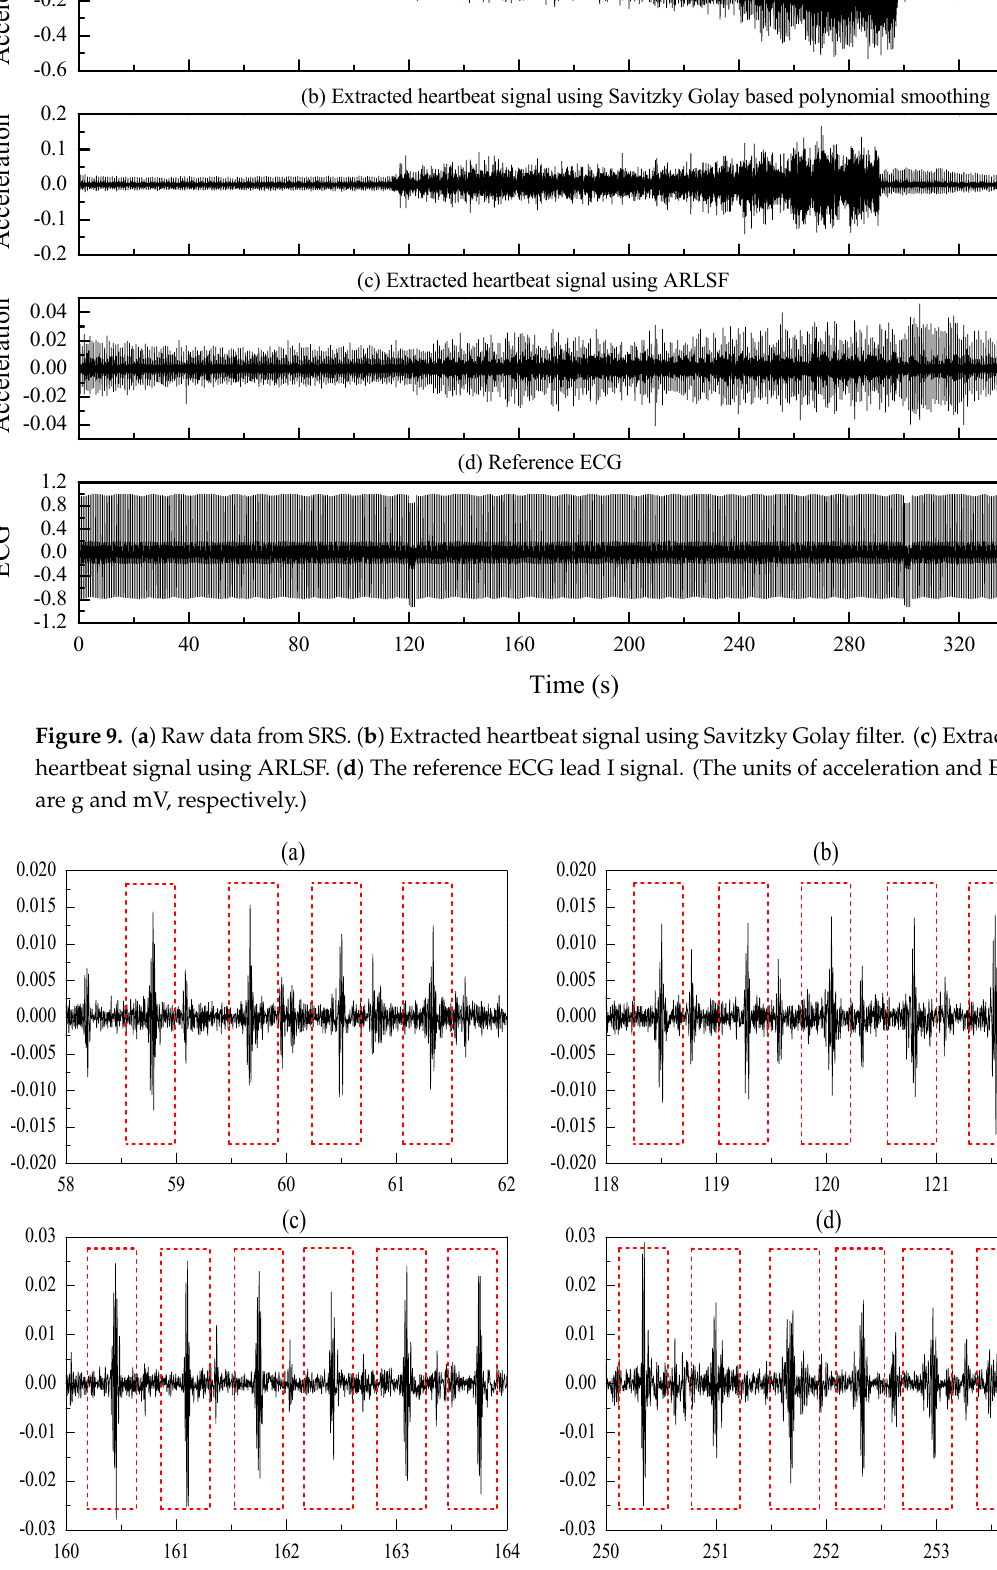
Figure 10. ( a – f ) Segmented signal during standing before walking, transitions from standing to walking, the first half of walking, the second half of walking, transitions from walking to standing, standing after walking. (The x ‐ axis and y ‐ axis are time in seconds and acceleration in gravity respectively.) 4.1. Heartbeat Detection Accuracy The standard ECG lead I recordings are the baseline references for heartbeat signals. Heartbeat detection accuracy is defined as the ratio of the detected SCG peaks divided by the detected ECG peaks. The detected SCG peaks are visually noticeable and marked with the red dotted line in Figure 11. In addition, the missing SCG peaks are also considered to give a more precise estimate of detection accuracy. These peaks represent the undetected and false ‐ positive detected SCG peaks. The blue rectangular, which is marked in Figure 10, can be considered as an undetected SCG peak using the rule of feature extraction described previously. This method is used even though the features and graphs of the signal are visually noticeable. Numbers in the brackets represent the missing peaks that occur at the beginning and end of walking in Table 1. It can be observed that above 60% of the missing SCG peaks occur at the beginning and end of walking when MA changes rapidly. The detection rates, which are shown in Table 1, are higher than 98%. 296